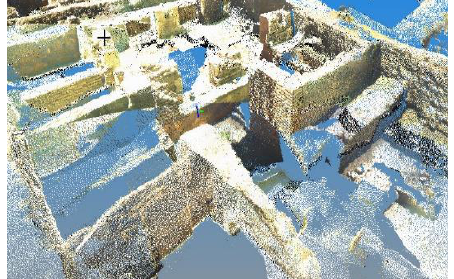
Figure 4. Point cloud